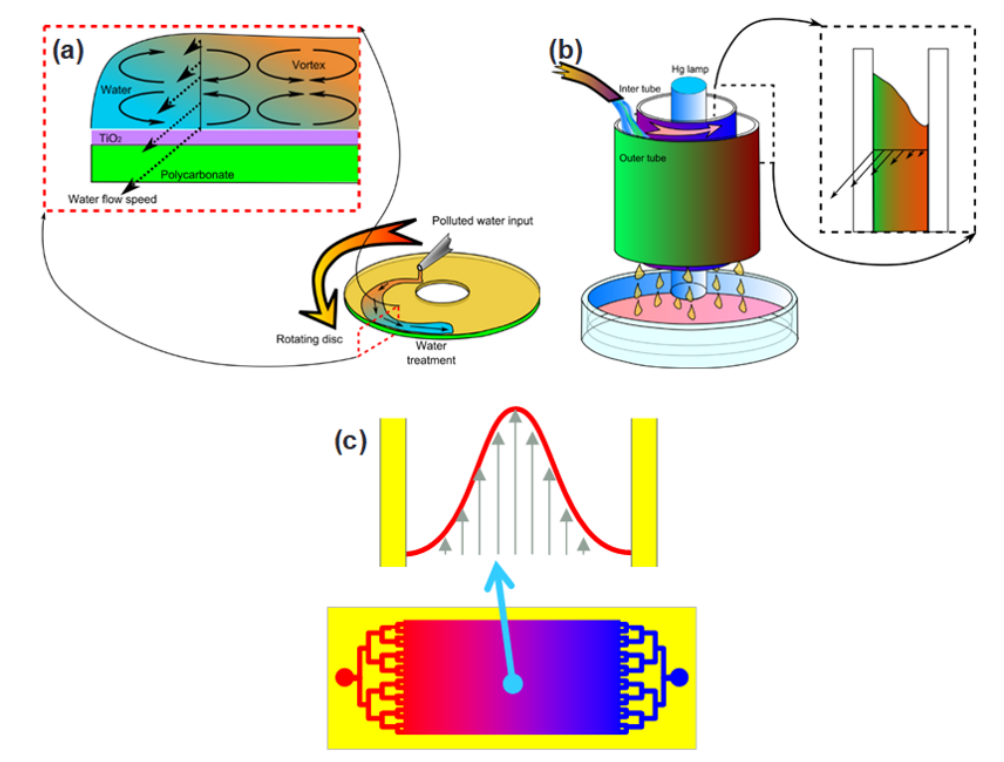
Figure 3. High-efficiency photocatalytic reactors: ( a ) spinning disk reactor, ( b ) Taylor vortex reactor, and ( c ) micro-optofluidic chip